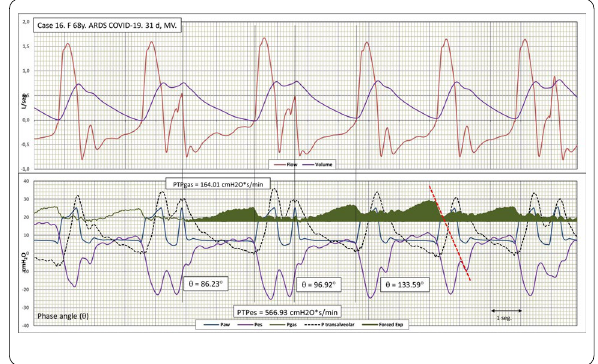
Sedation level: RASS -2–3. Figure 1: Representative case of Pseudo- Reverse triggering due to forced expiration.